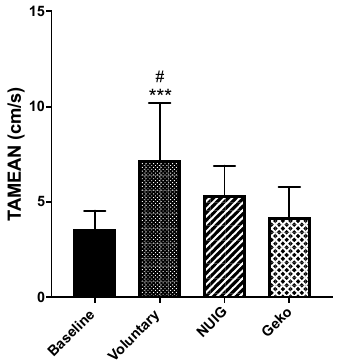
Figure 3. The e ff ect of intervention on TAMEAN (cm / s). TAMEAN were significantly increased in voluntary ( n = 24) in comparison to baseline ( n = 24). Voluntary contraction showed significant difference with Geko ( n = 9). (*** P < 0.0001 versus baseline; # P < 0.001 versus Geko) Data shown as ± SD.